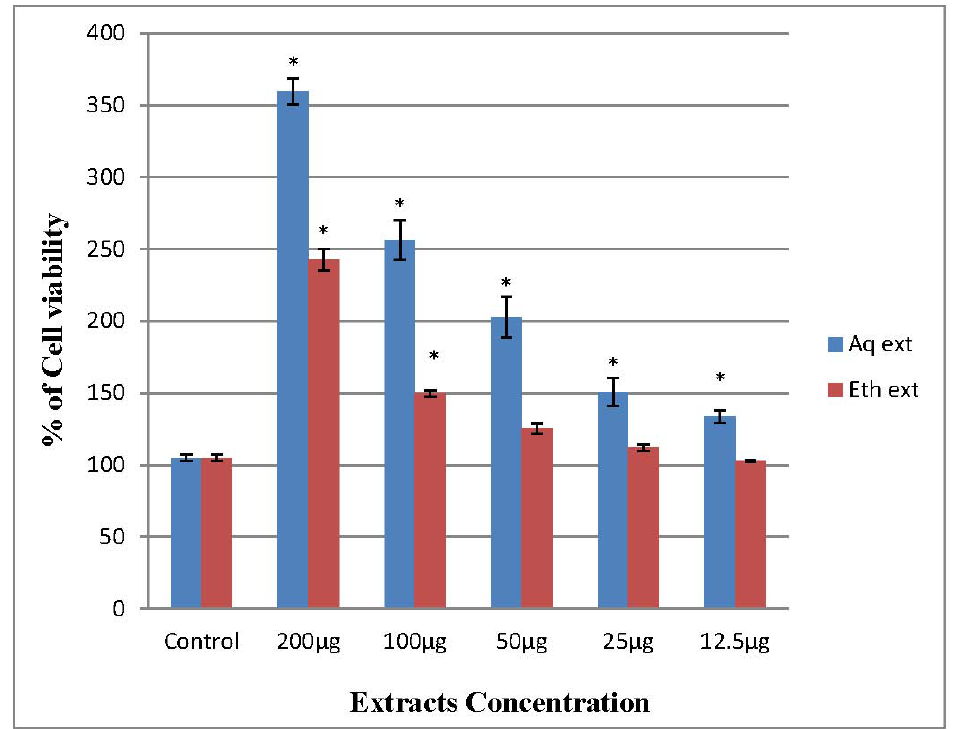
Figure 1. Percentage of (PBMCs) cell viability of O. stamineus treated groups compared to control (untreated